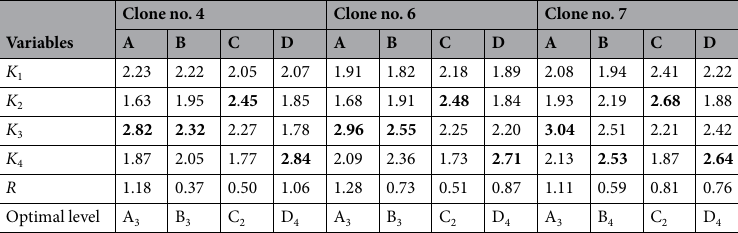
Table 4. Range analysis of L 16 (4) 4 test results for root length. The optimal level is in bold.